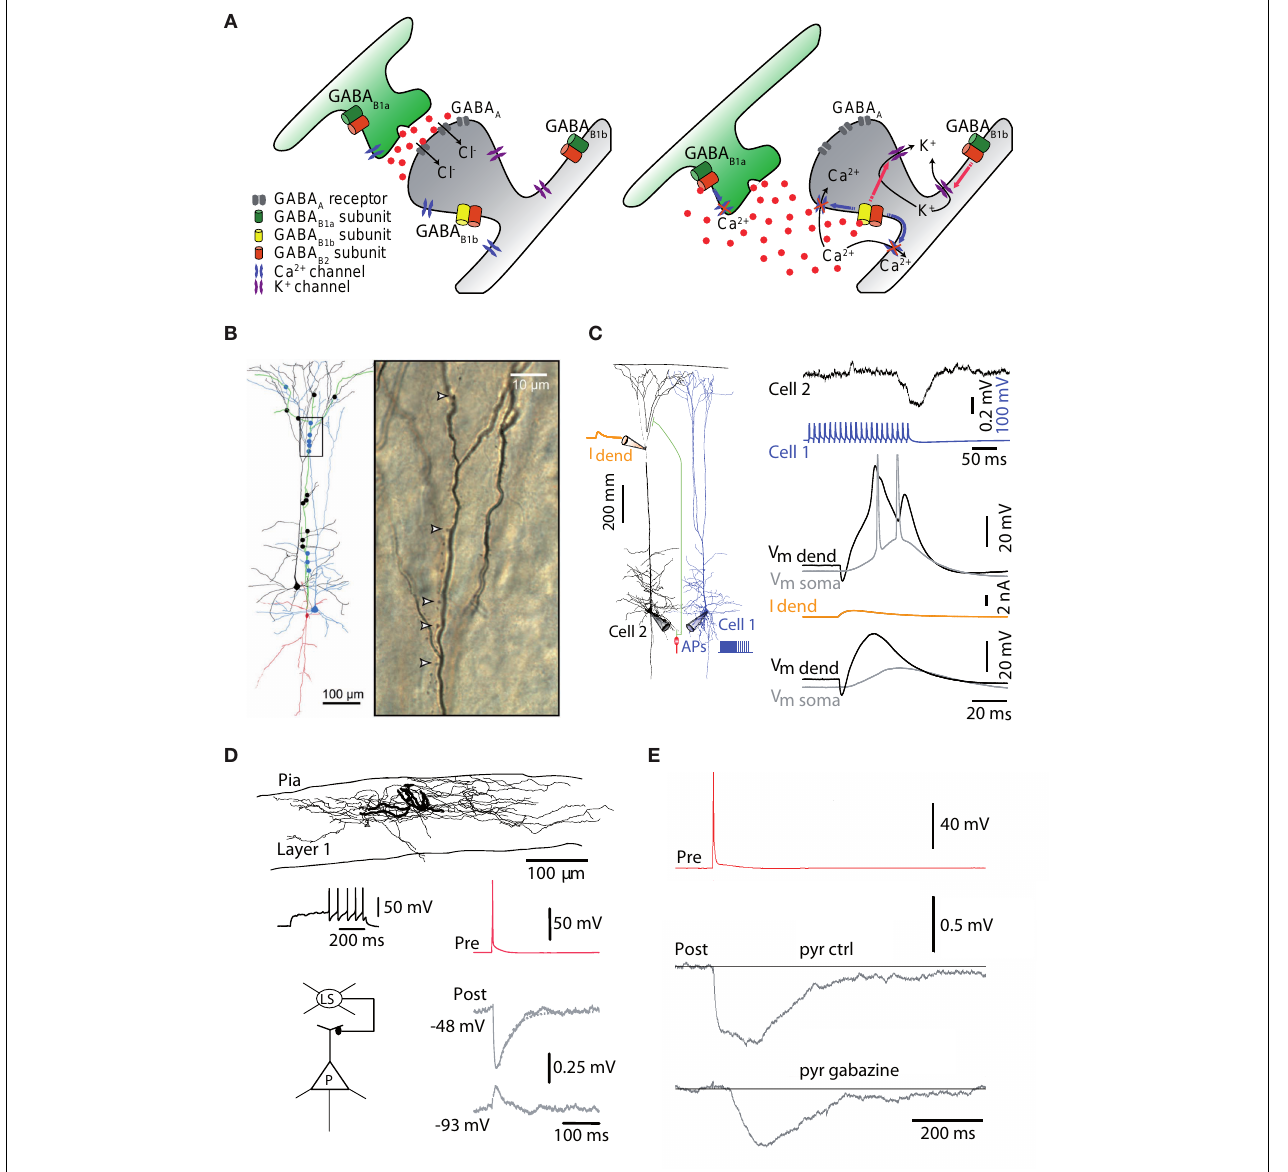
FIGURE 2 |Types of dendritic inhibition. (A) Ionotropic, GABA A inhibition shunts the dendrites and spines via conductance of Cl − and HCO 3 ions. GABA B receptors on the other hand, which operate metabotropically, have a range of actions and locations. Presynaptically, one isoform of the receptor tends to block Ca 2 + channels responsible for triggering the release mechanism. Postsynaptically, a different isoform of the GABA B receptor opens G-protein activated inwardly rectifying K + channels and blocks Ca 2 + and NMDA channels that control dendritic electrogenesis. GABA B receptors are found extrasynaptically where they are involved in “volume transmission” and tonic inhibition. (B) Martinotti neurons have been shown to mediate disynaptic inhibition between neocortical